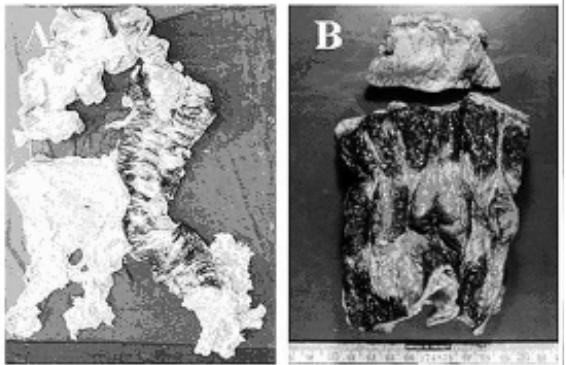
Fig. 1 - Caso 1: A – Alças intestinais ressecadas; B – Detalhe de alça ressecada com a pigmentação devida à provável melanose